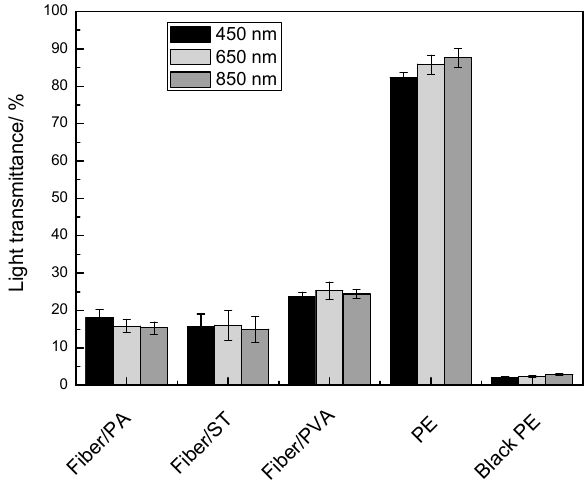
Figure 3. Photopermeability of the four tested films.